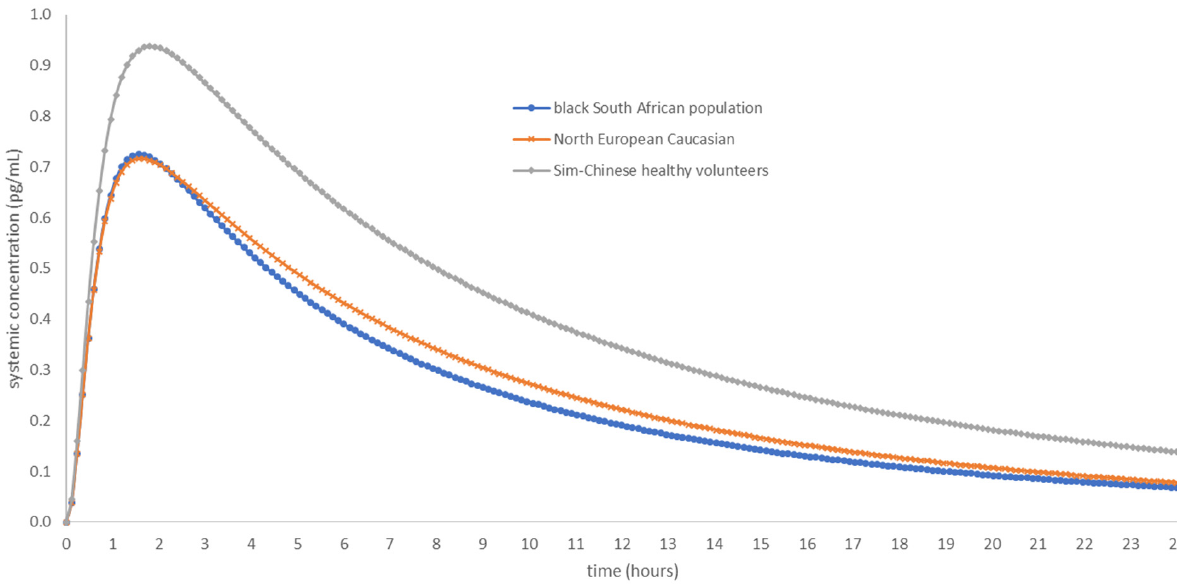
Figure 4. Systemic AFB1 concentration (pg/mL) versus time (h) curve in a Sim-Chinese healthy volunteer population of 5000 subjects (grey line), in a Sim-NEur Caucasian population of 5000 subjects (orange line) and in a Black South African population of 5,000 subjects (blue line) over a time span of 24 h. Table 6. Summary of the predicted PK parameters for healthy Chinese volunteers, North European Caucasians and Black South Africans by simulating 5000 virtual subjects. Sim-Chinese Healthy North European Cau- Black South African Sim-Chinese North European Volunteers casian Healthy Volunteers mean C max (pg/mL) 0.967 mean T max (h) mean AUC 0–24h (pg/mL.h) mean AUC 0–24 h